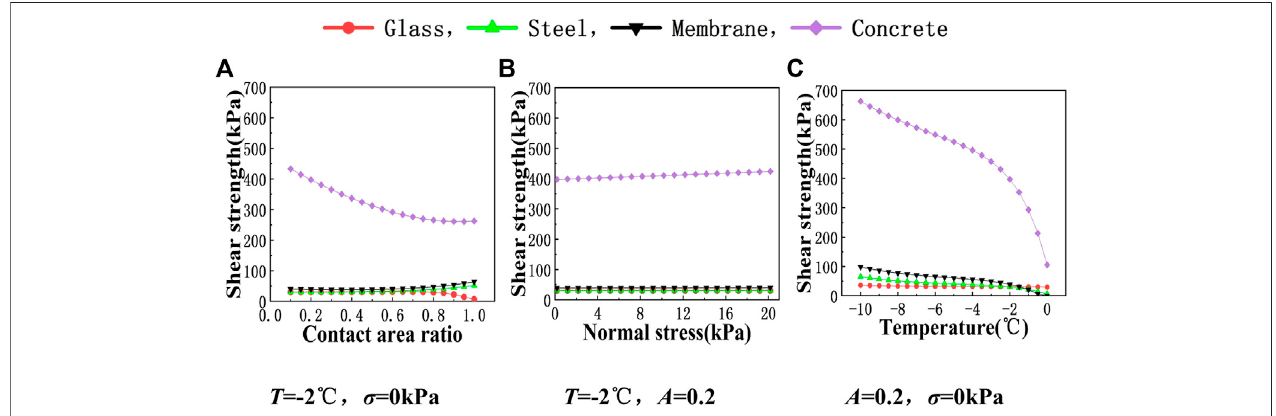
FIGURE 13| Examples of the predicted shear strength: (A) variation ofthe predicted shear strength with contact area ratiowhen T = − 2 ° C, σ = 0kPa, (B) variation of the predicted shear strength with normal stress when T = − 2 ° C, A = 0.2, and (C) variation of the predicted shear strength with temperature when A = 0.2, σ = 0 kPa.